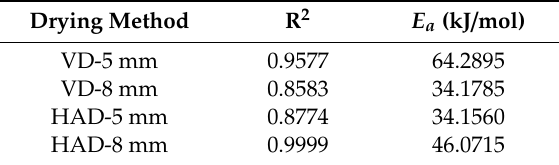
Figure 4. Arrhenius-type relationship of e ff ective moisture di ff usivity versus temperature for VD and HAD methods at di ff erent samples thickness levels. Table 3. Activation energy of persimmon fruit samples for VD and HAD at di ff erent thickness